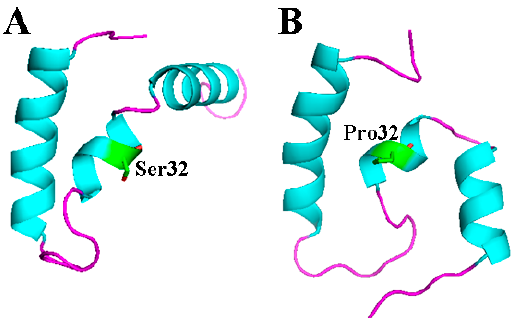
Figure 3. The comparison of the homology structure between EP-5 and Ds-26-16. The amino acid sequences of EP-5 and Ds-26-16 were submitted to Phyre2 server, respectively, for homology modeling in the intensive mode, which is based on a profile–profile alignment algorithm. ( A ) Ds-26-16; ( B ) EP-5. The blue parts stands for α -helixes, the green part is residue 32, and the purple line is loop.